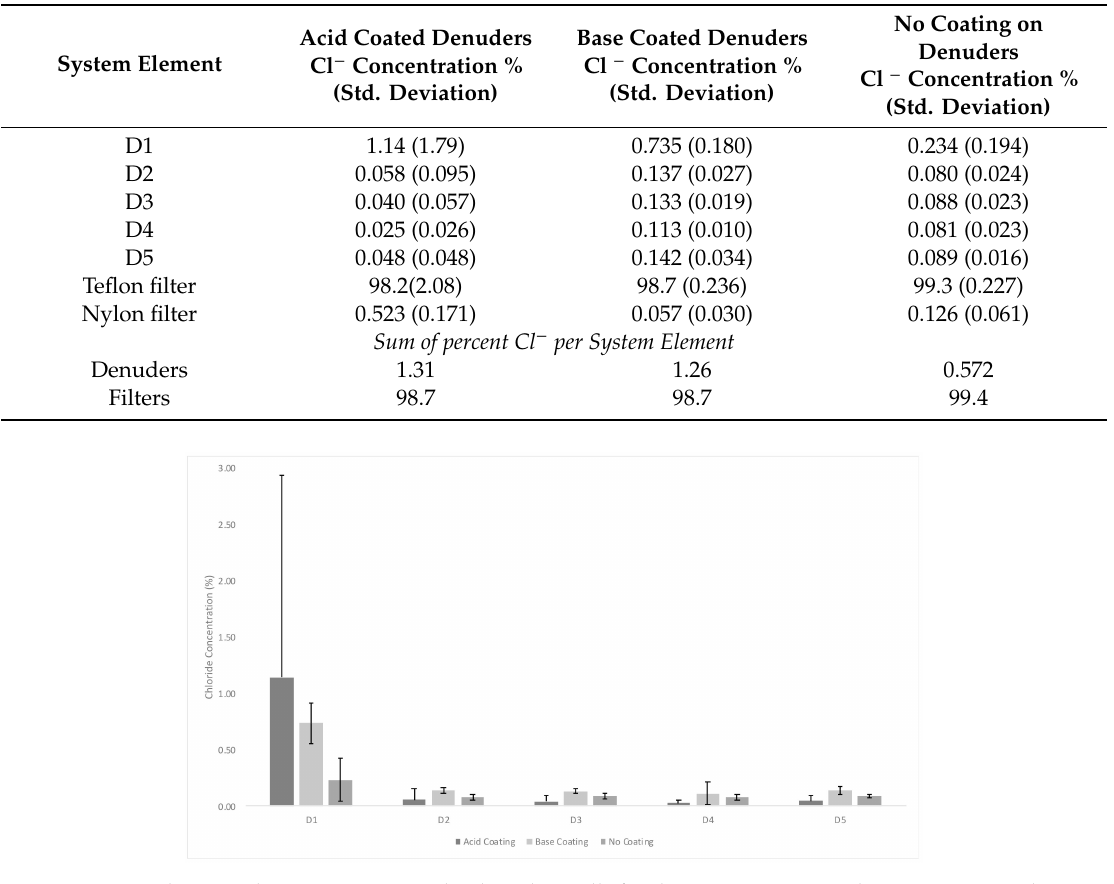
Figure 6. Cl − aerosol concentration on the denuder walls for the 5-ADS set-up. Values are given as the average percentage of the three trials conducted per coating type (acid, base, or no coating) for a total of nine